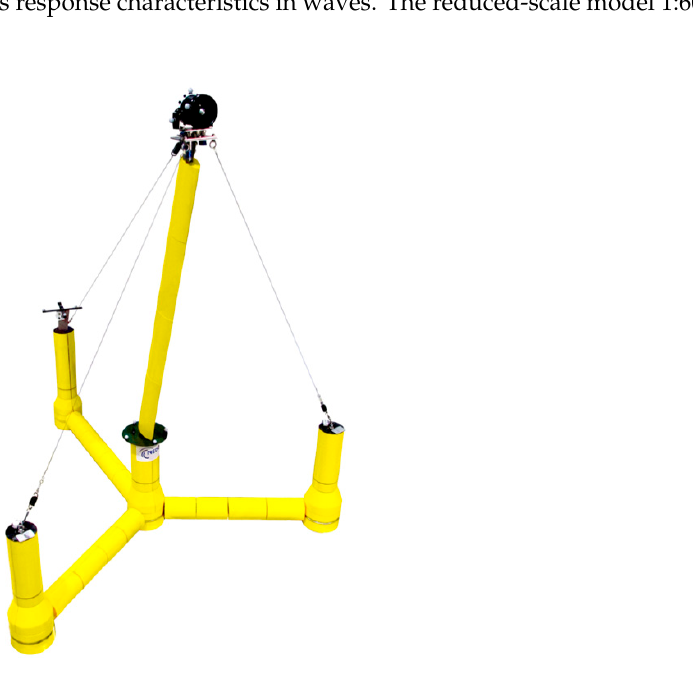
Figure 2. Elastic and dynamic similar segmented backbone model used in the experiments.